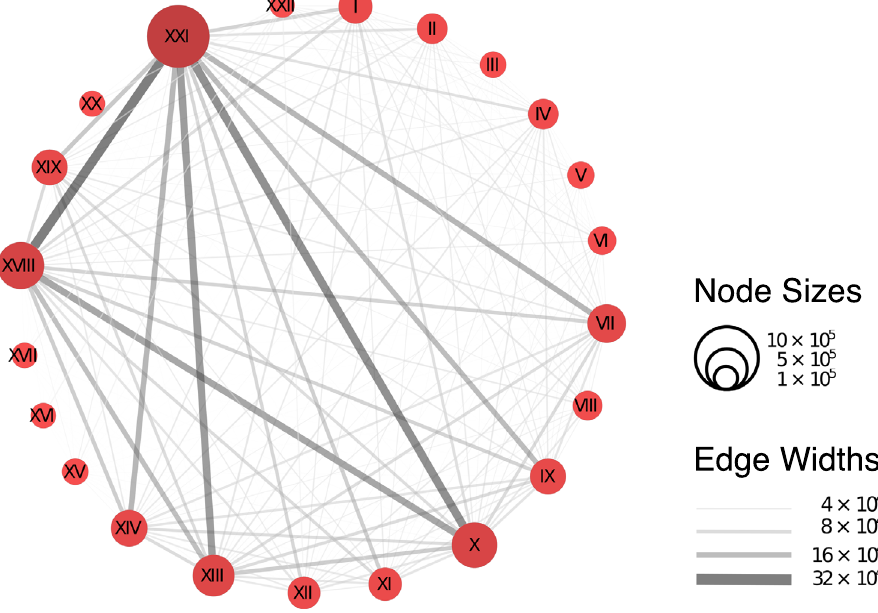
Fig 2. Network representation of the ICD-10 grouped in their 22 category chapters. The weight of the links represent the number of co-occurrences in the patients records and the size of the nodes represent the frequency of each chapter.